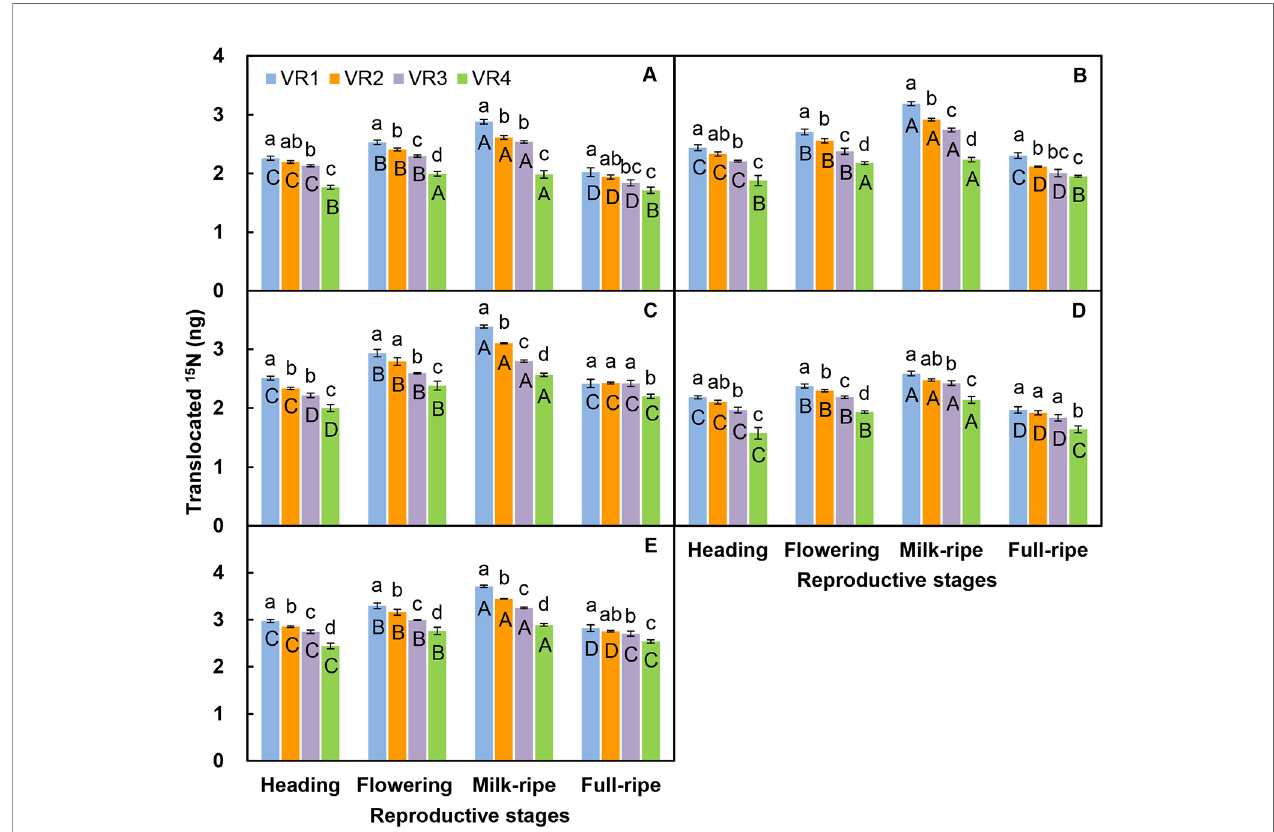
FIGURE 3 | Comparison on the amounts of translocated 15 N from labeled vegetative ramets toward leaf blade (A) , sheath (B) , stem (C) , in fl orescence (D) , and whole ramet (E) of basipetal reproductive ramets among the four treatments of position order (VR1, the fi rst acropetal vegetative ramet located on the tillering node; VR2, VR3, VR4, the second, third, and fourth acropetal vegetative ramets located on the rhizome) and among the four reproductive stages. Different small letters for the same stage indicate signi fi cant differences ( P < 0.05) among position orders, and different capital letters for the same position order indicate signi fi cant differences ( P < 0.05) among reproductive stages. Values are means ± standard error (SE). Note that the y -axes are log